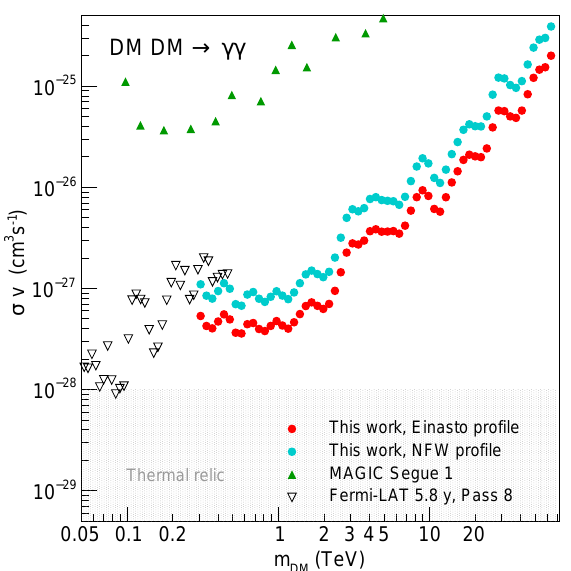
Figure 7: Upper bounds on the cross section for DM annihilation to γγ , from Fermi (black triangles), MAGIC (green triangles), and H.E.S.S (red and cyan dots). Red and cyan dots correspond to the Einasto and NFW profiles respectively. The gray-shaded area is a theoretical forecast for the natural scale of the line cross-section. Figure reproduced from Ref. [ 94 ] ; see that work for